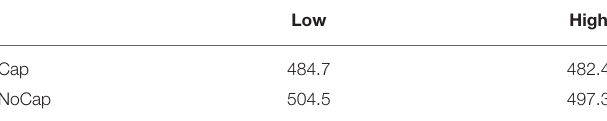
TABLE 6 | Mean Gaze durations (in ms) on the word group (Adjective + Noun) in both spelling modes split by Noun frequency in the EXP